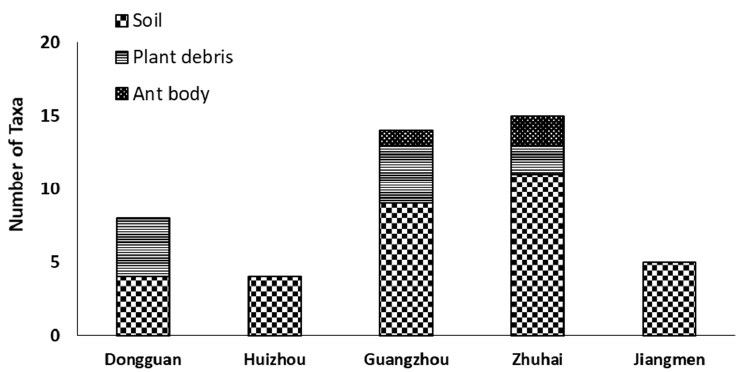
Figure 5. Endophytic fungal taxa cultivated from different substrates collected from five different cities of Guangdong Province, China.